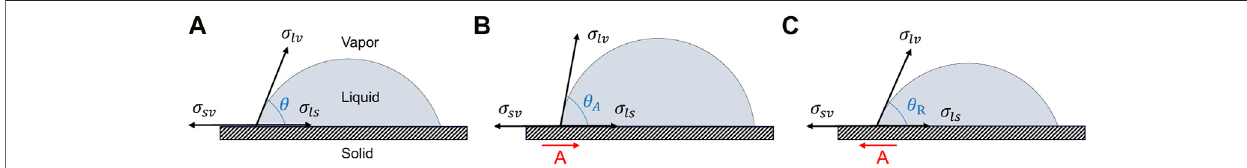
Frontiers in Mechanical Engineering |